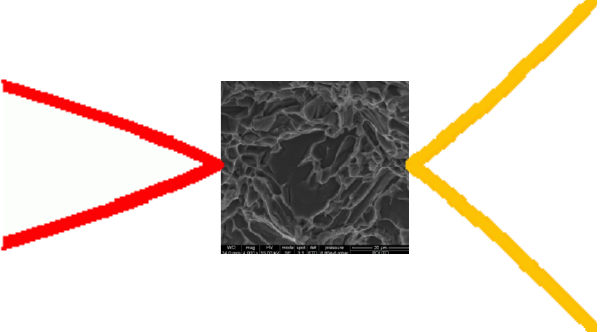
Figura 11: Sovrapposizione della zona plastificata di fronte all’apice della cricca di fatica in propagazione con la zona di frattura riportata in Fig. 4. Figure 11: Overposition of the plastic zone at the tip of a fatigue crack with the fracture area of Fig. 4.